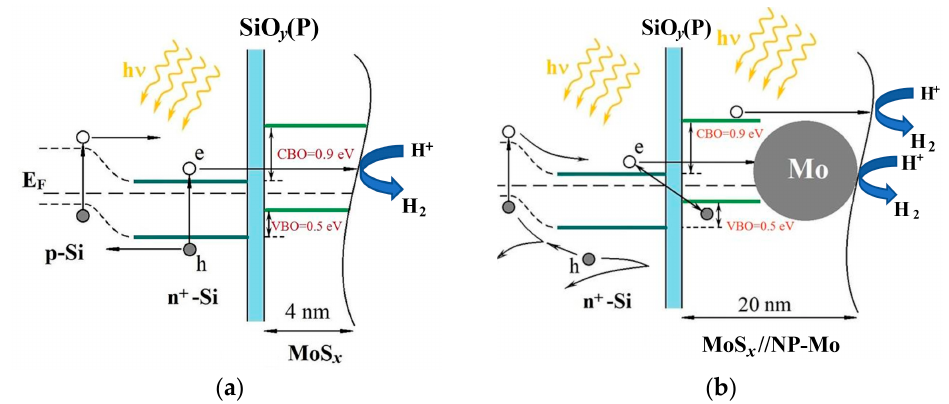
Figure 14. Energy band alignment and PEC HER mechanism for a-MoS x /NP-Mo//n + p-Si photocathodes covered with ( a ) 4 nm thick and ( b ) 20 nm thick a-MoS x /NP-Mo films. Explanations are given in the text.